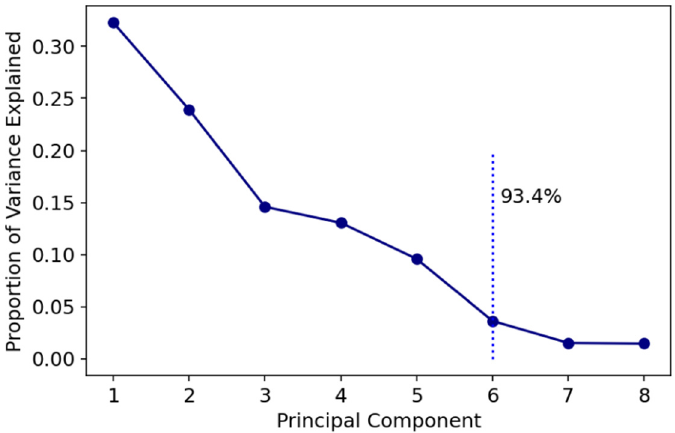
Figure 4. Scree plot, indicating that by incorporating 6 PCA inputs instead of the original eight, our model can achieve up to 93.4% of the input variance.